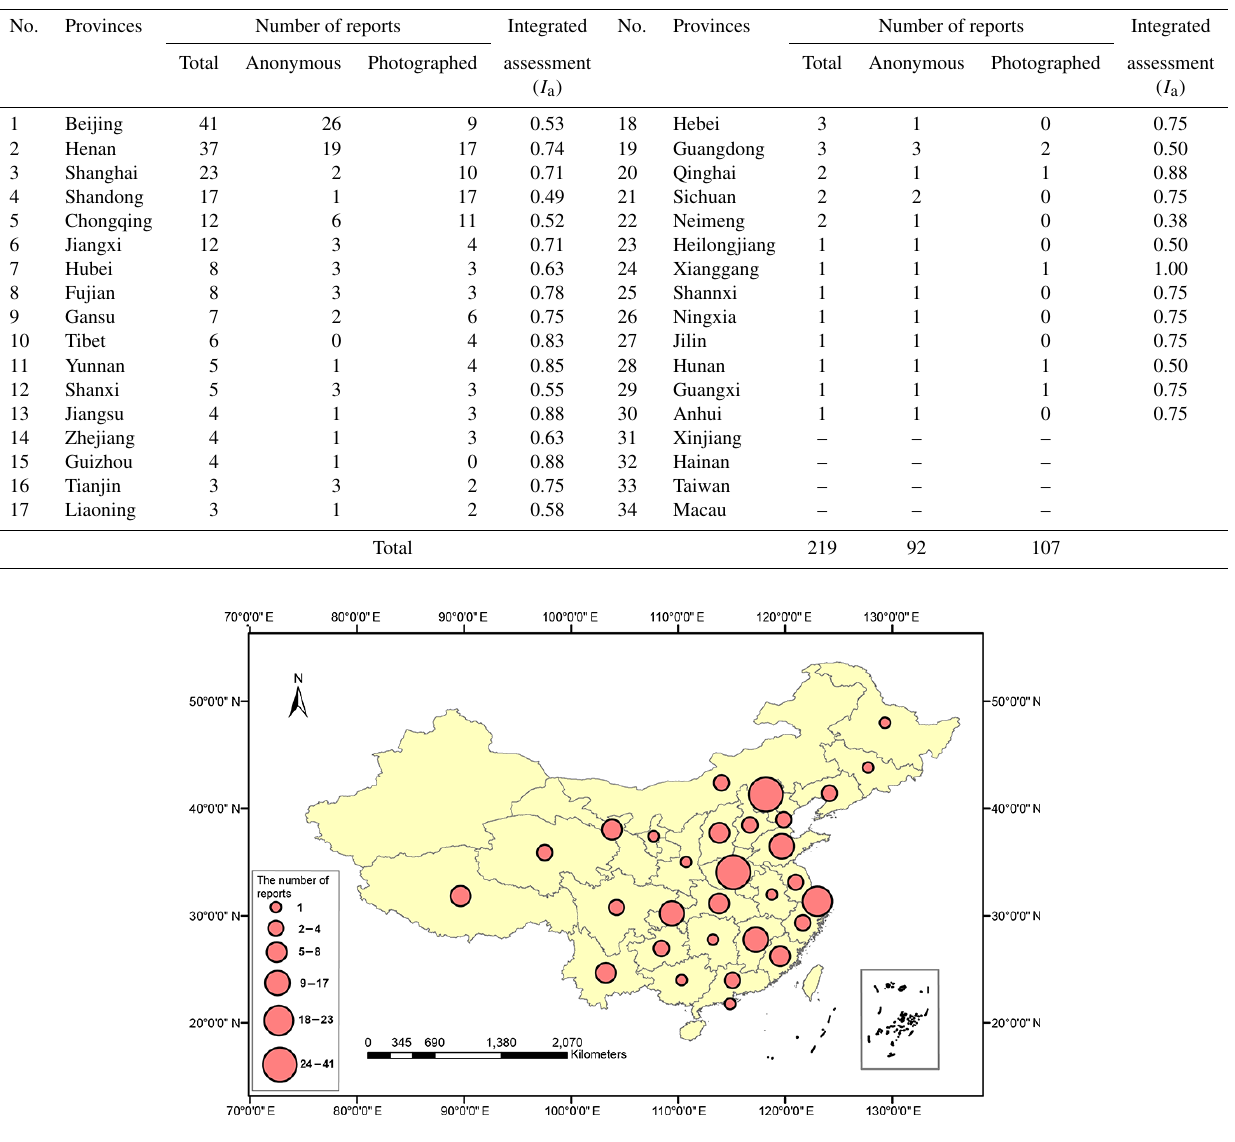
Table 2. Number of reports collected across China.